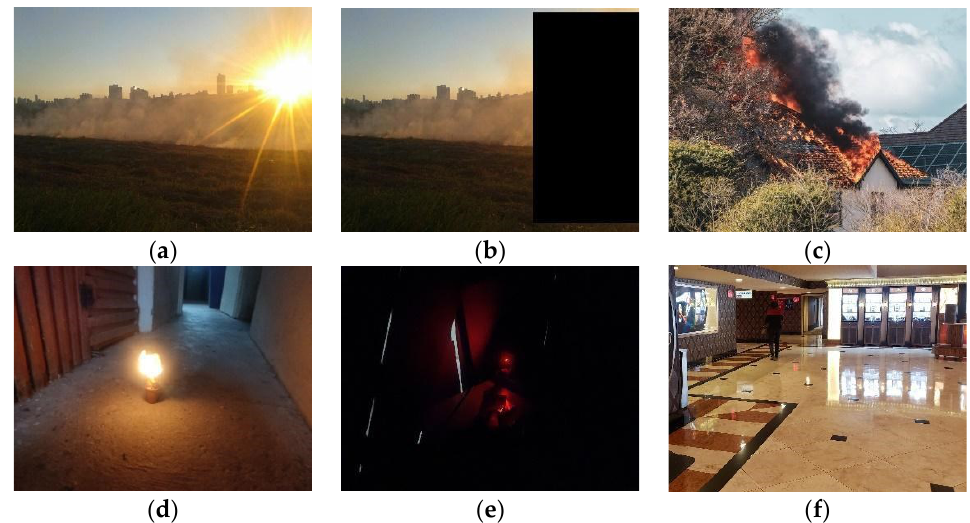
Figure 7. Examples of network inference on test images. A represents actual image class, P represents model-prediction class, and C represents the model’s confidence in its inference. ( a ) A: 1 P: 1 C: 97.21%. ( b ) A: 1 P: 0 C: 75.63%. ( c ) A: 1 P: 1 C: 99.91%. ( d ) A: 1 P: 1 C: 50.18%. ( e ) A: 0 P: 1 C: 88.48%. ( f ) A: 0 P: 0 C: 99.99%.